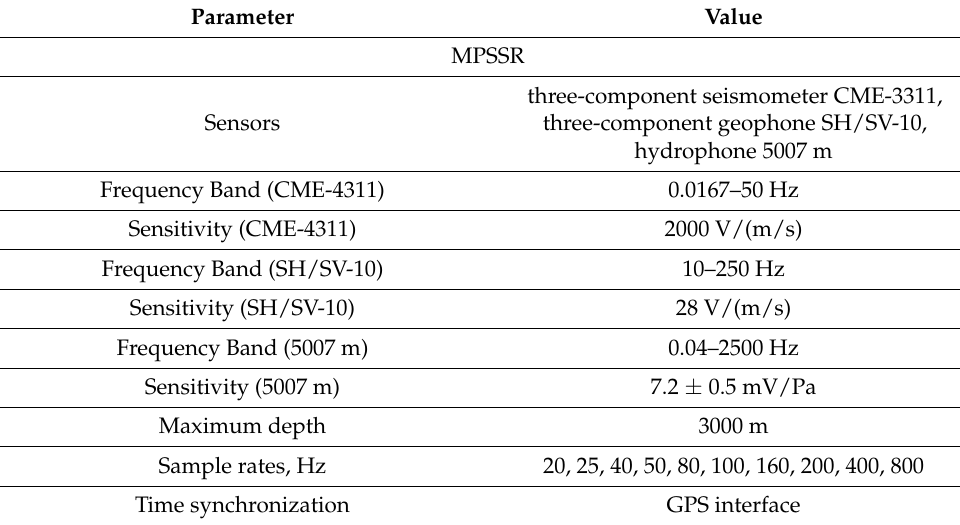
Figure 7. ( a ) The design of the MPSSR ocean-bottom seismograph: (1) three-component broadband seismometer CME-4311, (2) three-component short-period seismometer (SV-10 and SH-10) placed in gimbal, (3) hydrophone 5007 m, (4) recorder URS-S, (5) digital compass module, (6) battery block, (7) protective half-cover for hydrophone, (8) duralumin sphere, and (9) concrete ballast; ( b ) the design of the Typhoon ocean-bottom seismograph: (1) three-component short-period seismometer CME-3311, (2) hydrophone 5007 m, (3) recorder URS-S, (4) battery block, (5) protective half-cover for hydrophone, (6) duralumin sphere, and (7) concrete ballast; ( c ) MPSSR external view on the R/V Akademik Mstislav Keldysh, autumn 2018; ( d ) Typhoon external view on the R/V Akademik Mstislav Keldysh, autumn 2019; ( e , f ) the design of the GNS and GNS-C ocean-bottom seismographs: (1) Three-component broadband seismometer CME-4111, (2) recorder GNS, (3) acoustic modem, (4) batteries block, (5) acoustic hydrophone, (6) seismic hydrophone, (7) penetrator, (8) glass spherical housing with diameter 430 mm, (9) anchor, (10) lamp, (11) flag, (12) anchor release, (13) plastic case. ( g ) GNS, and ( h ) GNS-C external view on the R/V Akademik Mstislav Keldysh, autumn 2018 and 2019 correspondingly. Table 5. Main technical characteristics of the non-self-popup OBSs. Parameter